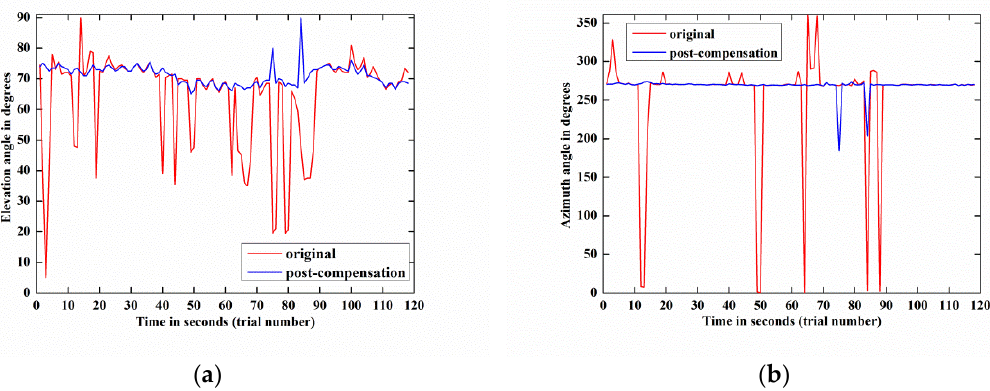
Figure 12. 2-D DOA estimation performance comparison between the original and post-compensation of weak target signal-1 by 118 trials: ( a ) Elevation angle; ( b ) Azimuth angle.